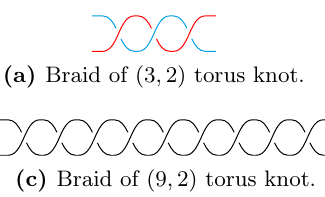
Figure 6. The braids corresponding to the type II (cid:12)bers in the g -tube, which have b = 1.